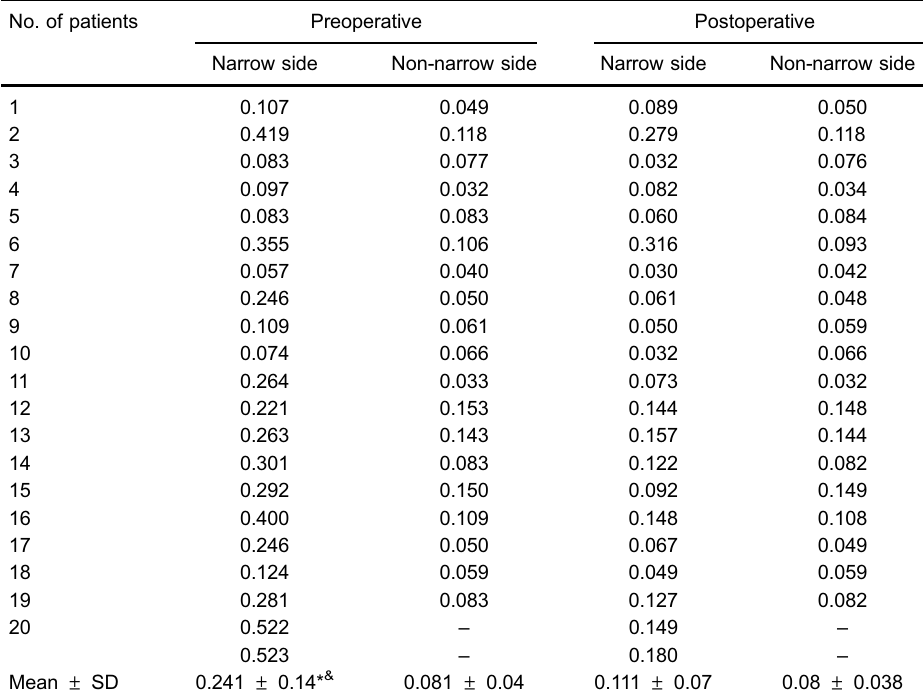
Table 5. Nasal resistance of 20 patients (in Pa .